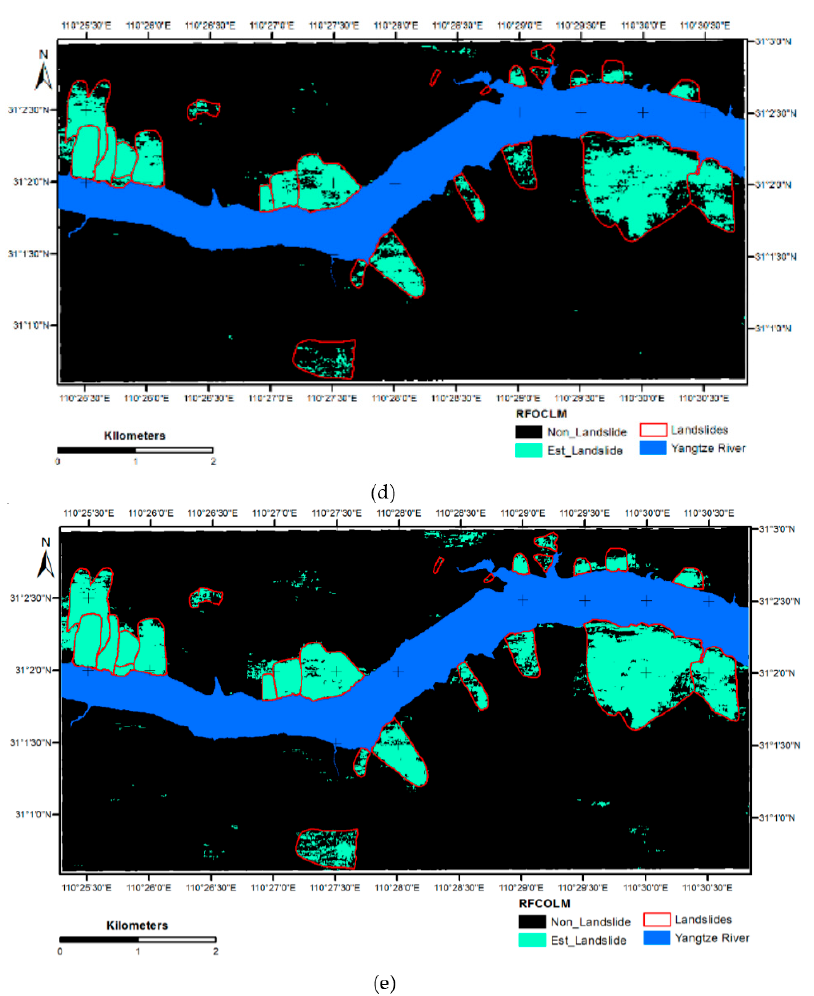
Figure 5. Landslide mapping results. ( a ) RFLM. ( b ) RFCLM. ( c ) RFOLM. ( d ) RFOCLM. ( e ) RFCOLM. Table 4. Quantitative evaluation of the proposed methods in the study area together with the estimated standard deviations (The bolded number means the highest accuracy in each row).